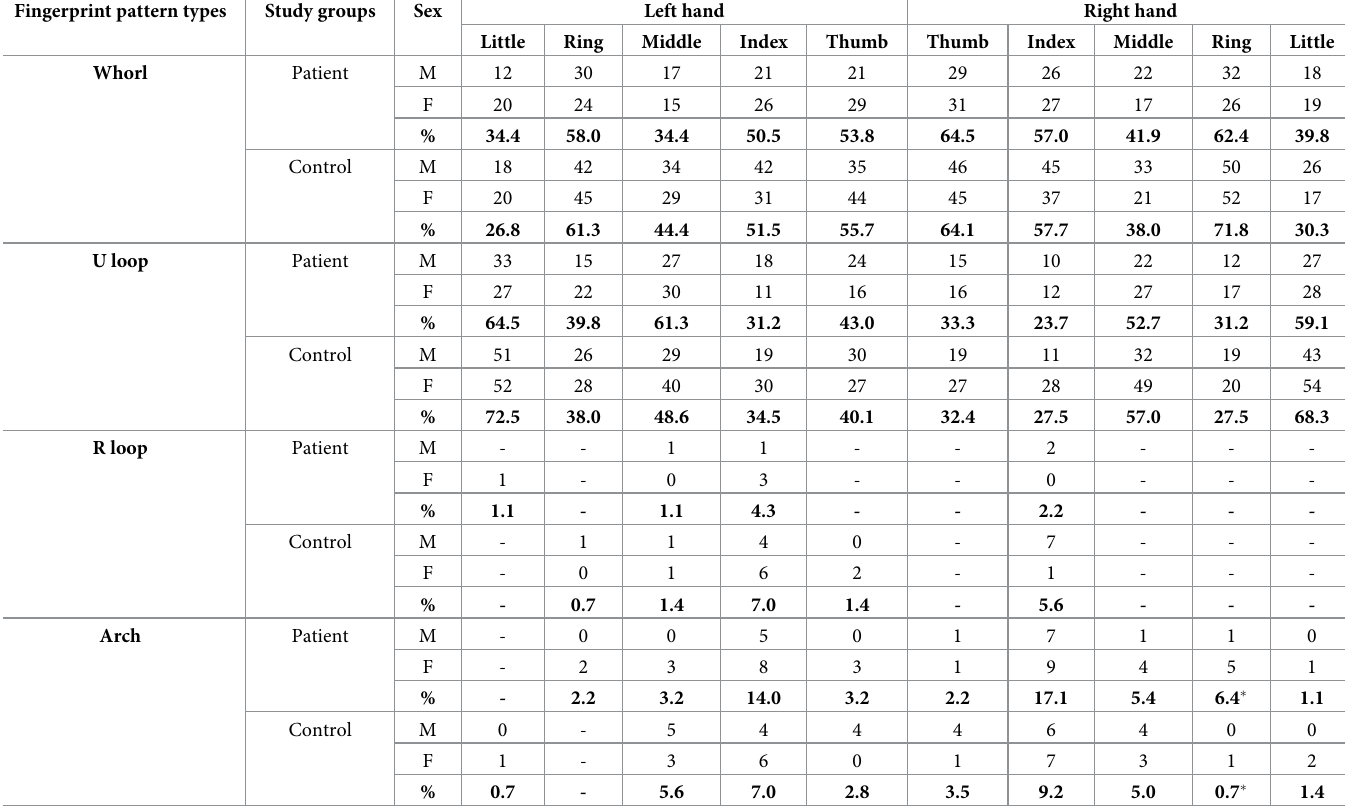
Table 2. Numbers and percentage of fingerprint pattern types in right and left hands. Fingerprint pattern types